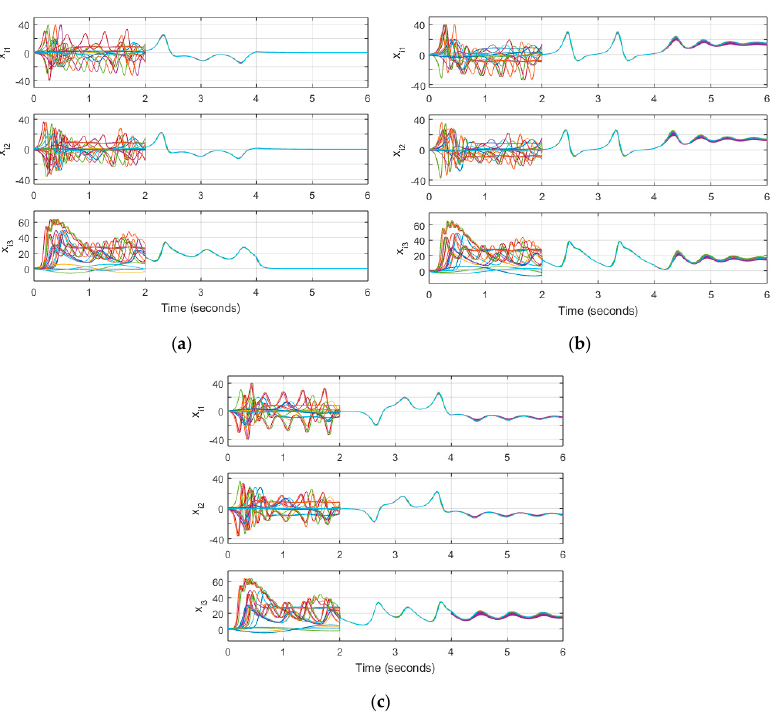
Figure 8. Complex network node dynamics when there are two controlled nodes, there is no noise in the system, control gains are d 3 = d 4 = 200, and: ( a ) Control input is applied at every time step; ( b ) Control input is applied every 5T; ( c ) Control input is applied every 10T. Mathematics 2020 , 8 , x FOR PEER REVIEW